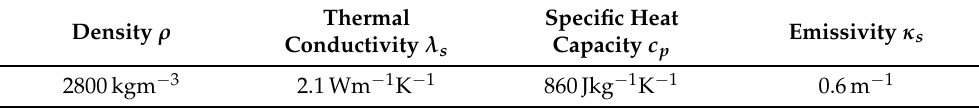
Table 2. Thermal properties of the refractory wall.